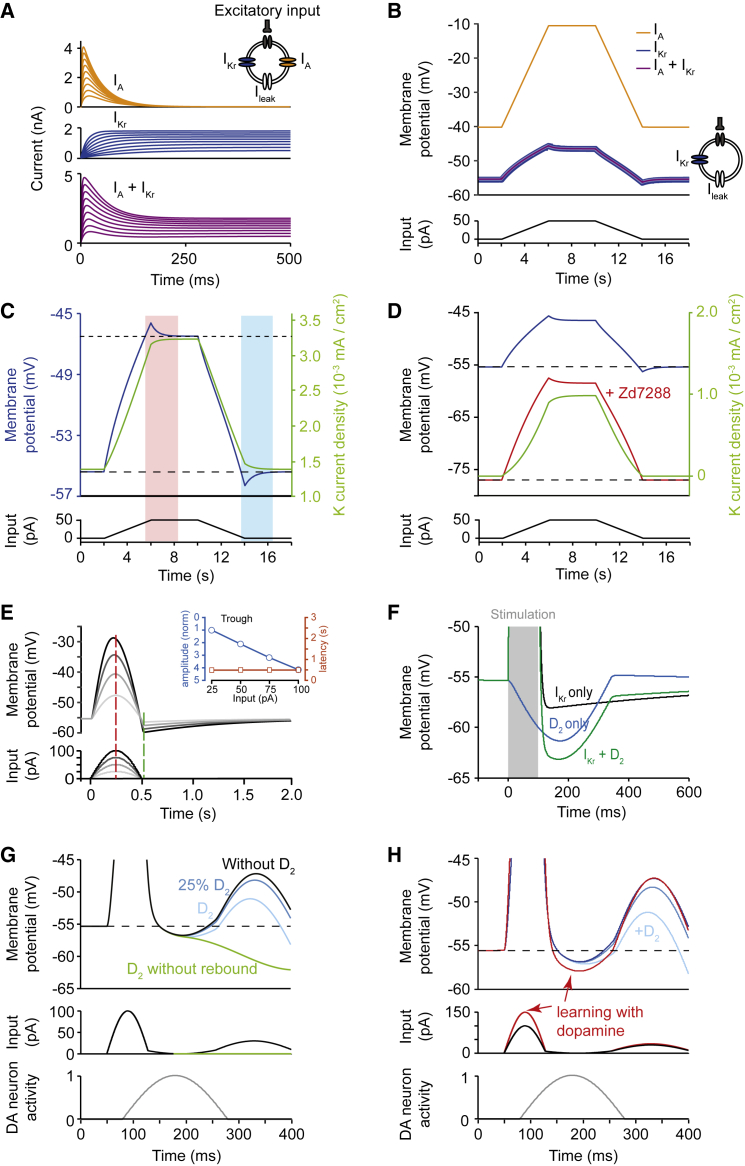
IKr Underlies Hyperpolarization and Interacts with Dopamine in a Model ChI(A) Current-time responses of conductances, 20 mV steps from −100 mV; inset: single-compartment neuron model.(B) Membrane potential response to synaptic input (current), with Ileak and IKr and/or IA.(C) IKr current density (green) and membrane potential (dark blue) showing overshoot (pink area) and undershoot (blue area).(D) Undershoot lost (red) at membrane potential −80 mV is restored with depolarization to normal RMP (blue).(E) Response to short sine-wave input. Maximum current injection (red dash); undershoot (green dash). Inset: trough amplitude (blue), but not latency (orange), scales with amplitude of current injected.(F) Effect of D2 current and IKr after separate and combined activation after a stimulation (gray area) starting at time zero.(G and H) Membrane potential response (top) to input to ChIs (middle) flanking a DA neuron burst (bottom) with 100% (light blue) or 25% (dark blue) of D2 currents identified in Straub et al. (2014) before (G) and after (H) enhanced excitatory input following learning (Suzuki et al., 2001). In (G), response without rebound (green). Ileak present throughout.